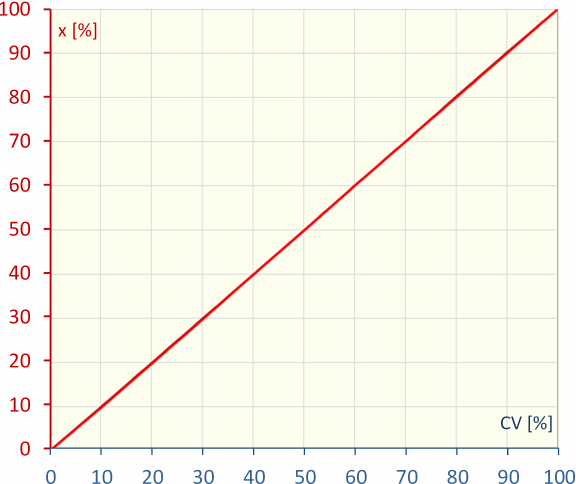
Figure 18. Illustration of the autotuner quality on example static characteristics of the normal action of a final control element with actuator type Masoneilan 37-09 under nominal operating conditions. Here, the initial hysteresis of the assembly: pneumatic actuator–control valve was 10%